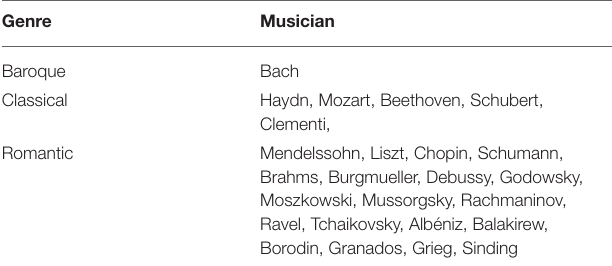
TABLE 2 | The basic information of musicians and their